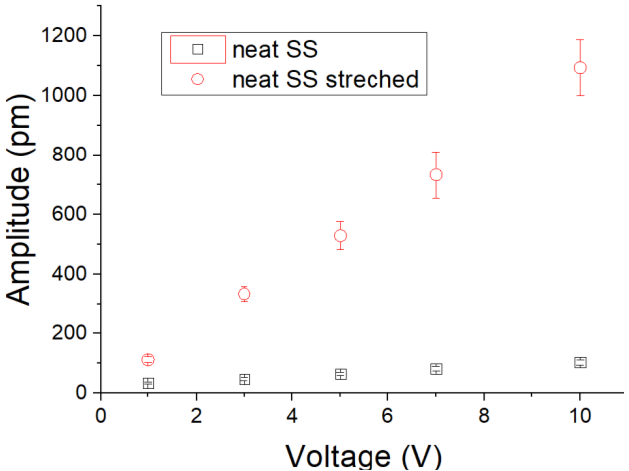
Figure 7. Mechanical deformation amplitude at different applied voltages for spider silk mats under normal conditions and under mechanical compression.